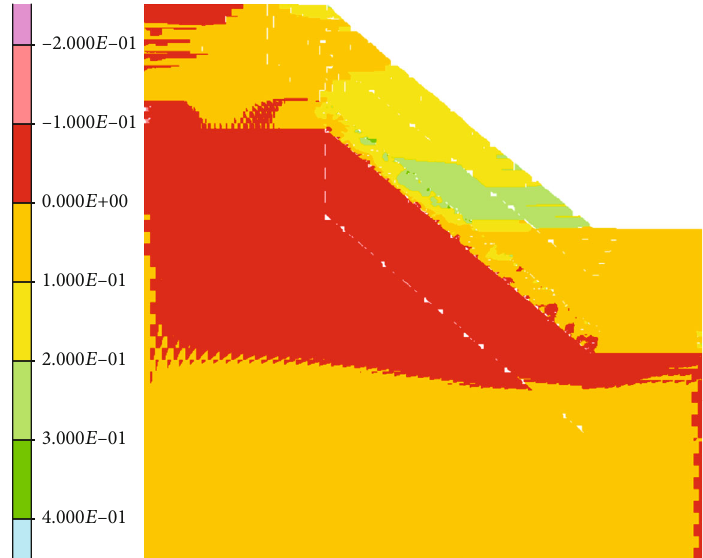
Figure 9: Displacement cloud diagram in the xx direction when running 80,000 steps.